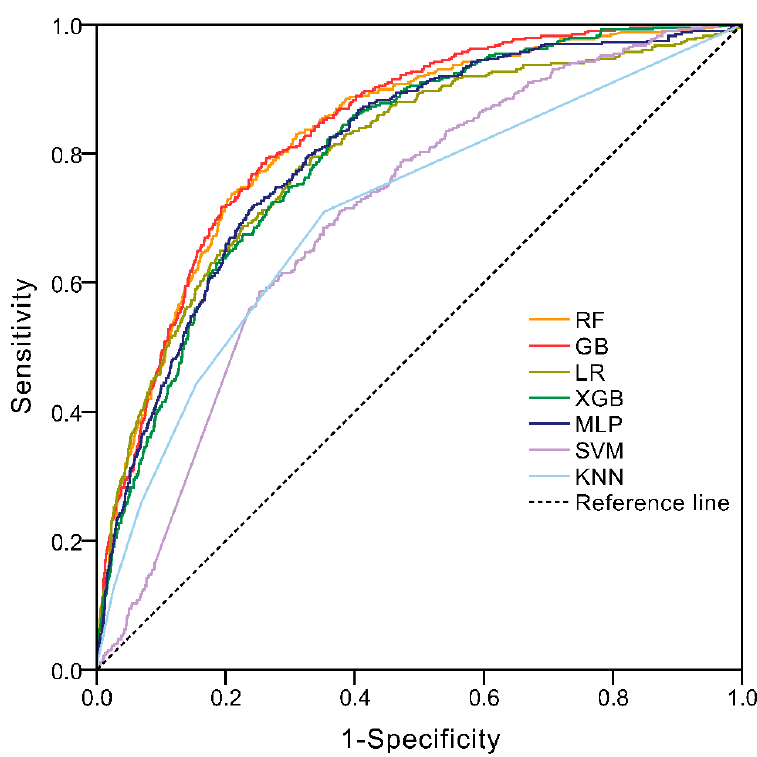
Figure 3. ROC of machine learning models in predicting HAT in the test set.